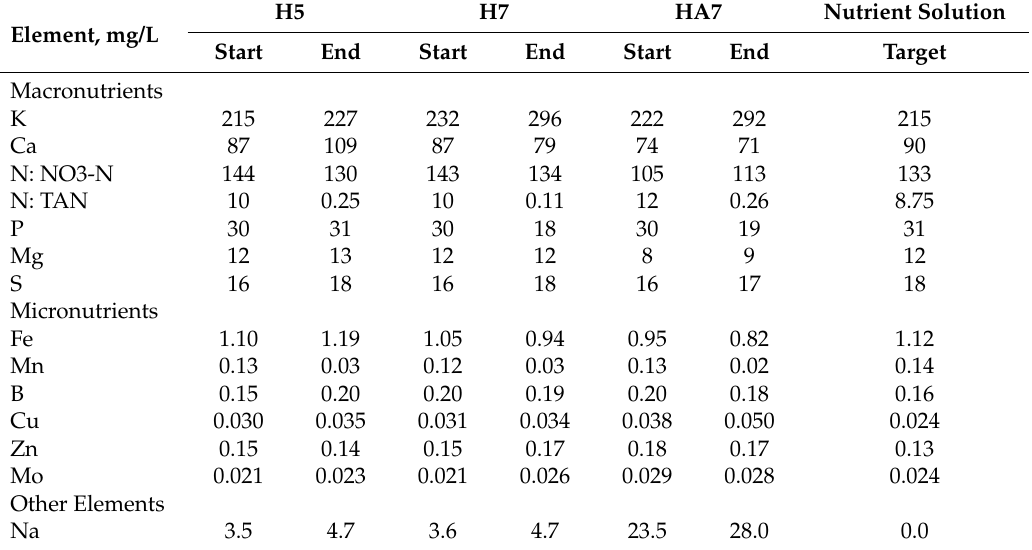
Table 1. Nutrient solutions starting, ending, and target concentrations, averaged by treatment (H5 = hydroponic conditions at pH 6.8; H7 = hydroponic conditions at pH 7.0; HA7 = hydroponic conditions at pH 7.0 and higher